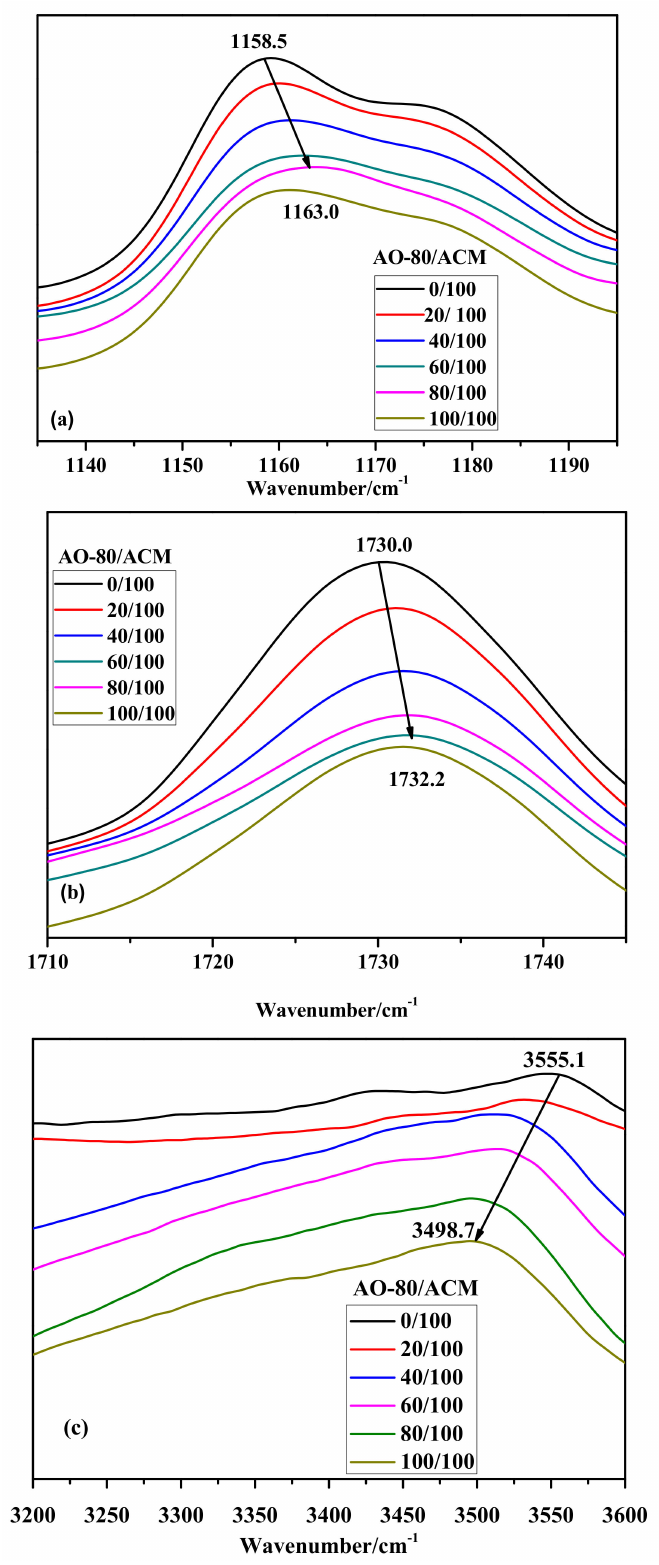
Figure 3. FT-IR spectra acquired at: ( a ) 1135 cm − 1 to 1195 cm − 1 ; ( b ) 1710 cm − 1 to 1745 cm − 1 ; and ( c ) 3200 cm − 1 to 3600 cm − 1 region for AO-80/ACM rubber